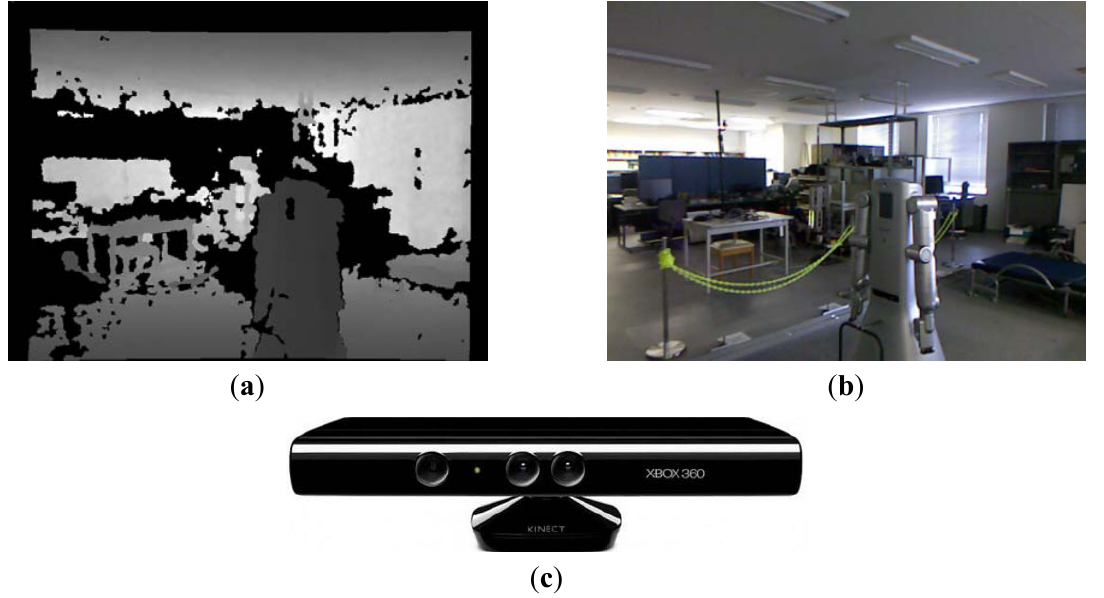
Figure 1. ( a ) Depth image obtained in a laboratory using the Kinect sensor. Different depths are shown using different grey values. Complete black pixels represent undefined values (see Section 3.2); ( b ) Corresponding RGB image representing the same scene; ( c ) The Kinect sensor used in our